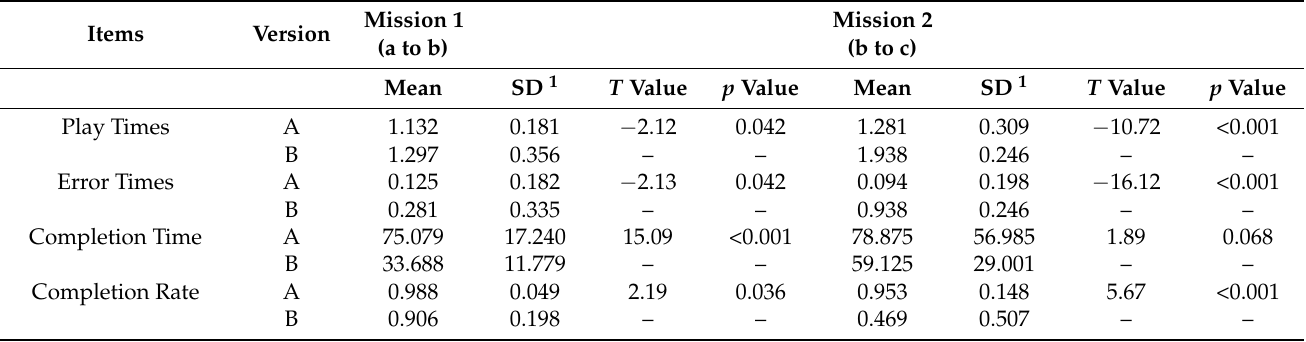
Table 2. Execution results of mission 1 and mission